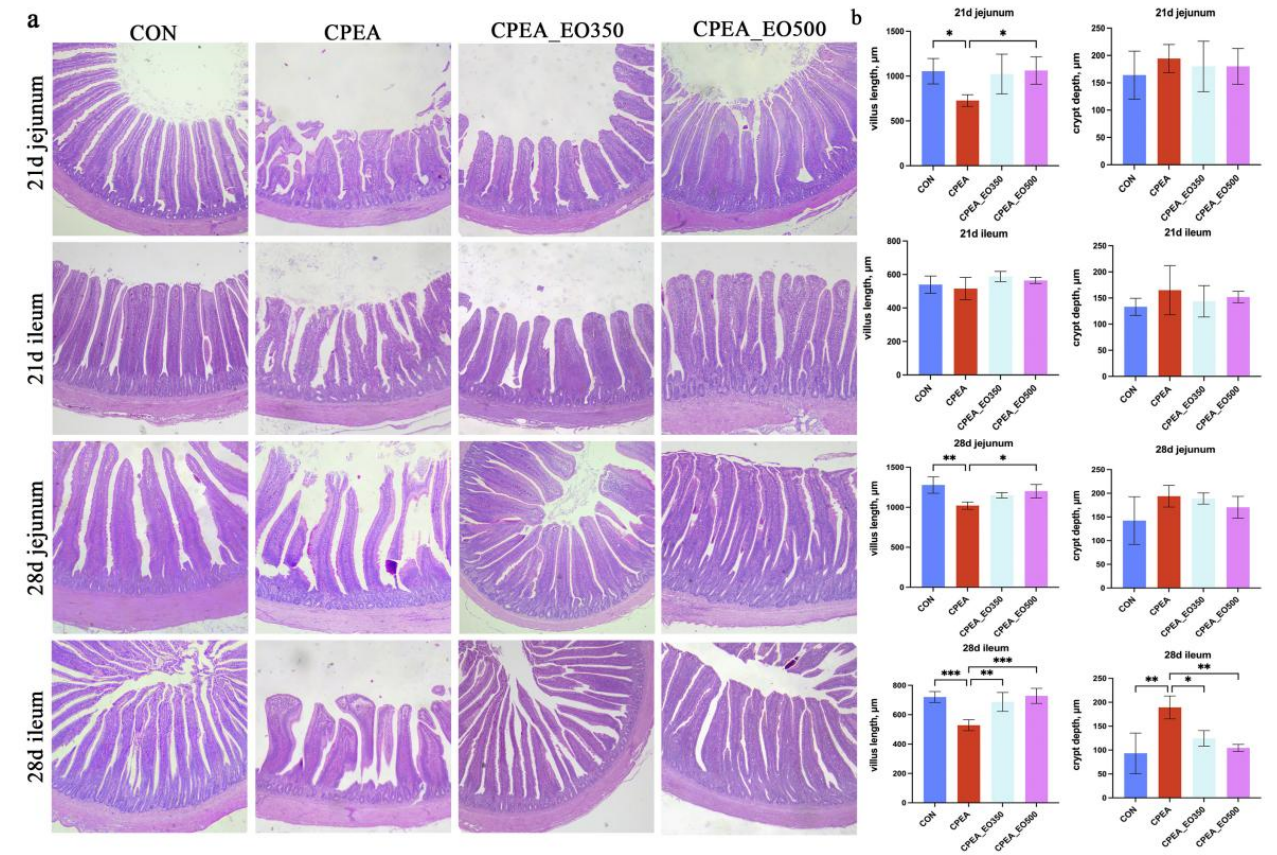
Figure 2. ( a ) Jejunal and ileal mucosa photomicrograph with typical crypts and villi. The scale bar is 200 µ m. Eosin and haematoxylin stain. Magnification is 100 × . ( b ) Crypt depth and villus height of jejunum and ileum. CON, control group birds fed a basal diet; CPEA, birds fed a basal diet and infected with Clostridium perfringens and Eimeria acervuline; CPEA-EO350, birds fed a basal diet supplemented with 350 mg/kg essential oils and infected with Clostridium perfringens and Eimeria acervuline; CPEA-EO500, birds fed a basal diet supplemented with 500 mg/kg essential oils and infected with Clostridium perfringens and Eimeria acervuline. Significant deviations are denoted by asterisks (* p < 0.05, ** p < 0.01, *** p < 0.001).